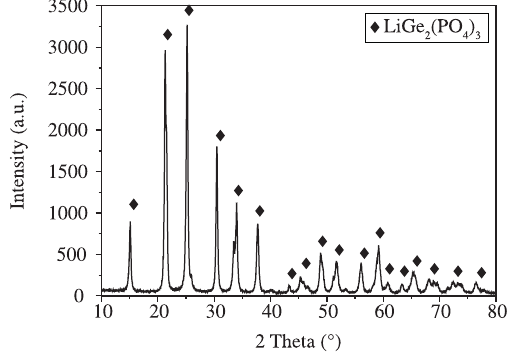
Figure 1. X-ray diffractogram of the Li glass-ceramic obtained at 610 °C after 20 minutes.